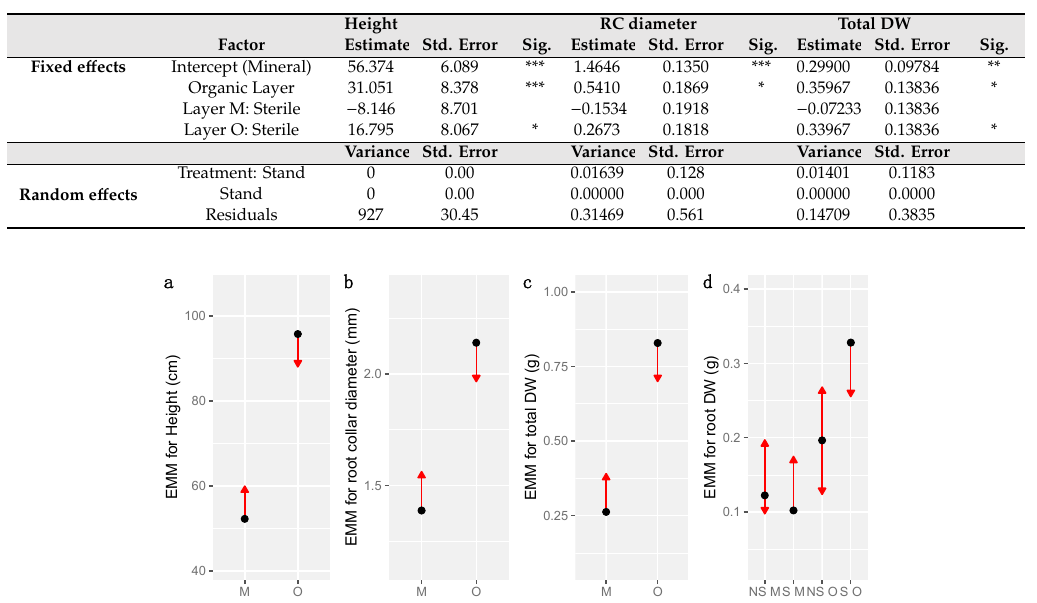
Table 2. LMM estimates for height, root collar (RC) diameter, total dry weight (DW). Std: standard error, p: p -value. *: p -value < 0.01, **: p -value < 0.001, ***: p -value < 0.0001. LMM formula: ~Layer + Layer / Steril + (1 | Stand / Treatment).